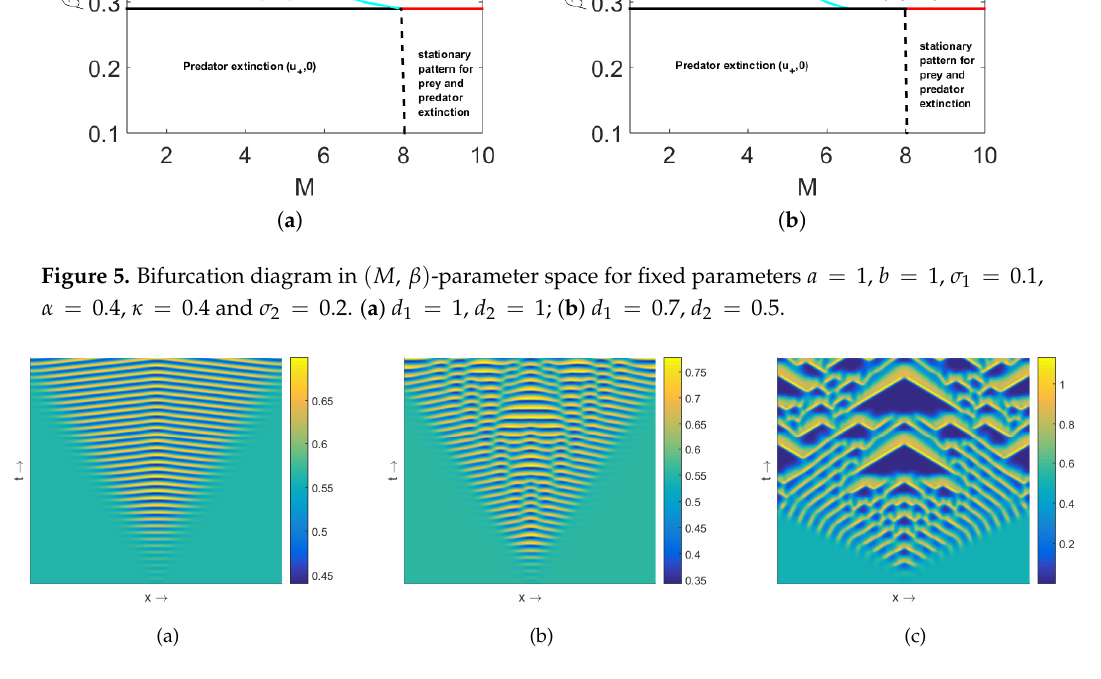
Figure 6. Spatio-temporal patterns produced by the nonlocal model with parameter values as mentioned at (1) with β = 0.342 and ( a ) M = 0; ( b ) M = 4; ( c ) M = 6.